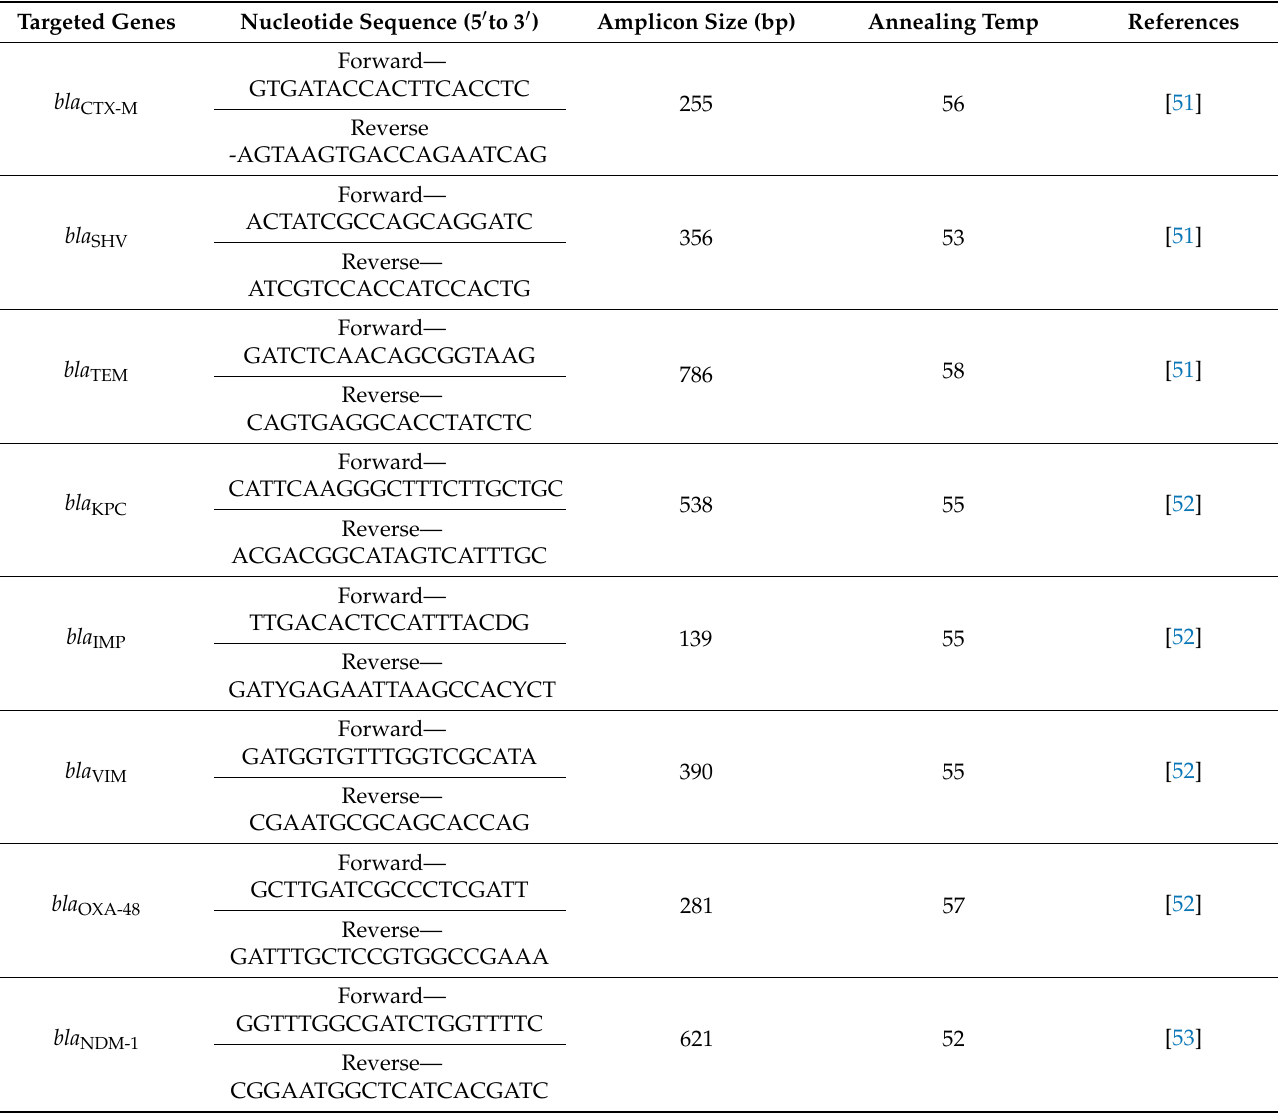
Table 2. List of primers